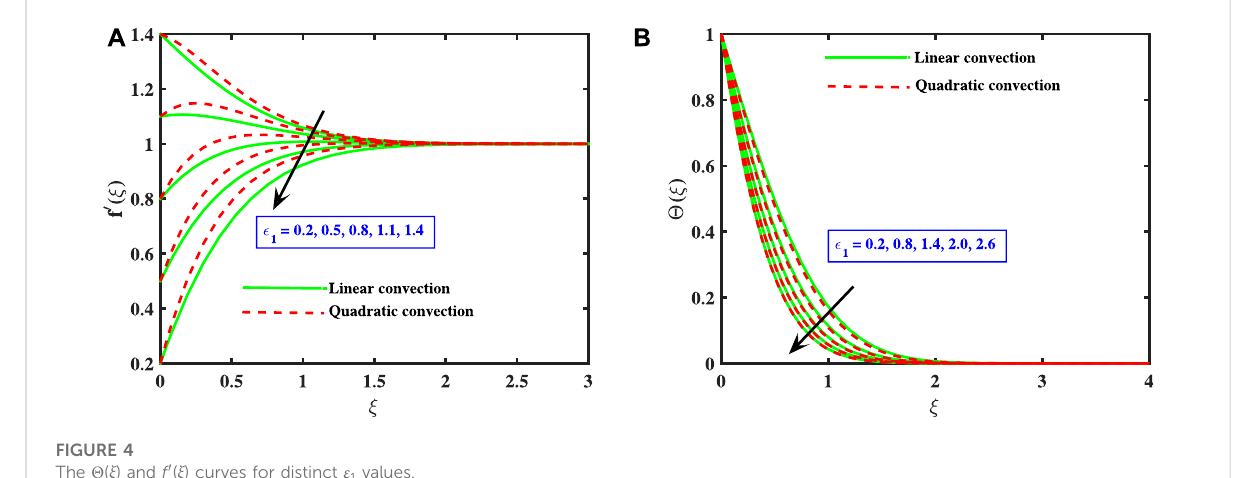
FIGURE 4 The Θ ( ξ ) and f ′ ( ξ ) curves for distinct ε 1 values.